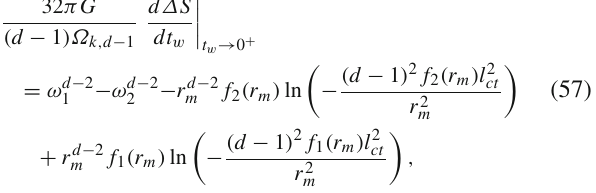
Fig. 4 The complexity of formation with respect to t w for the small time region with some small charges, where we set d = 3 , k = 0 , l ct = 1 , L = 1 ,ω 1 = 1 ,ω 2 =